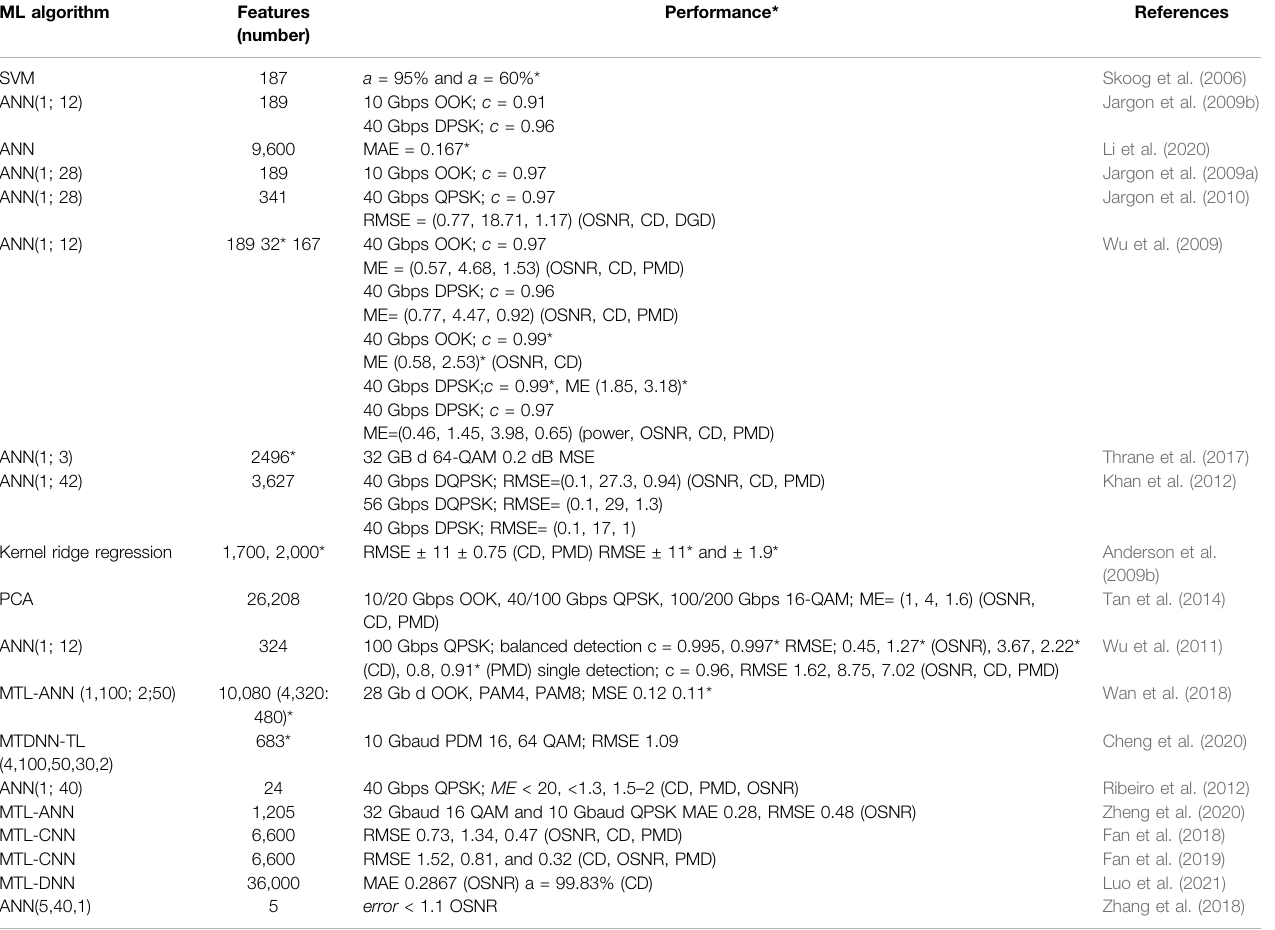
TABLE 3 | Performance comparison of existing OPM works for direct detection. ML